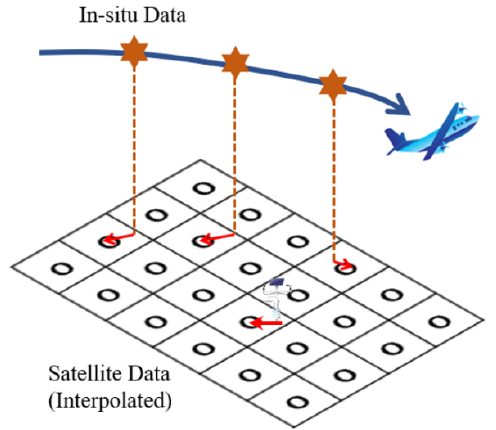
Figure 4. Spatial matchups of in-situ data with satellite data.